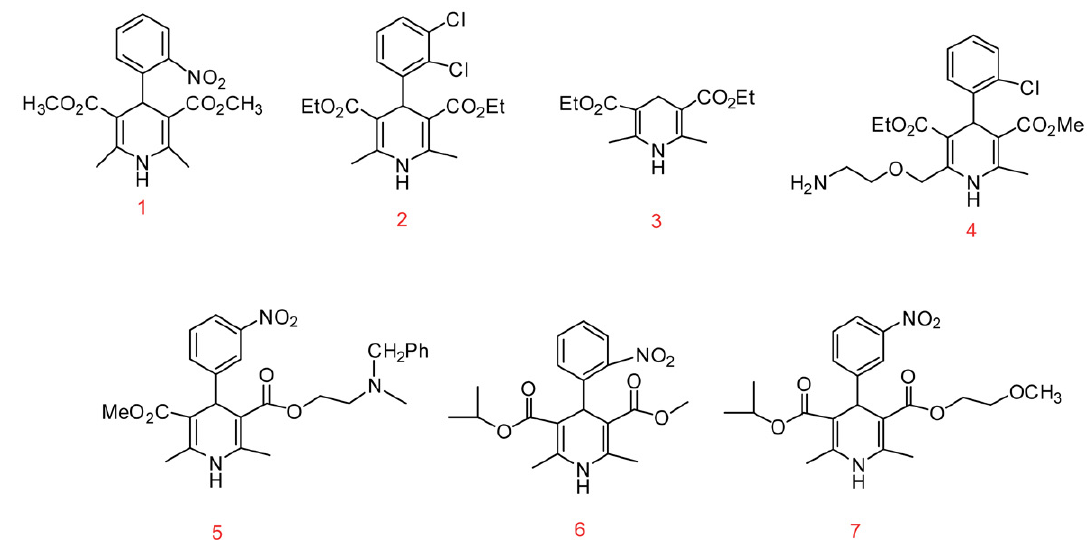
Figure 1. Some biologically active